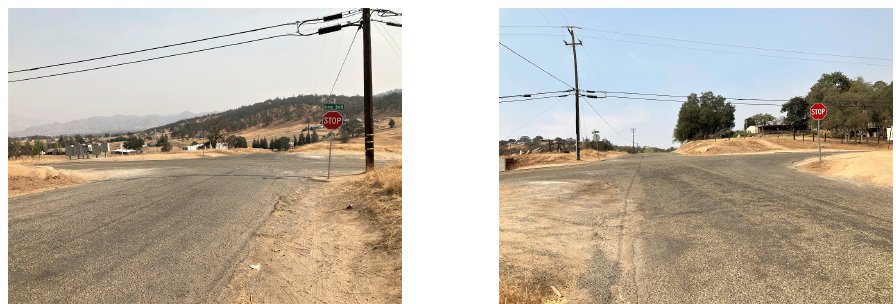
Figure 5. Example rural intersection from the point of view of vehicles traveling east–west through the intersection. Note that lack of visibility of traffic approaching in the north and south